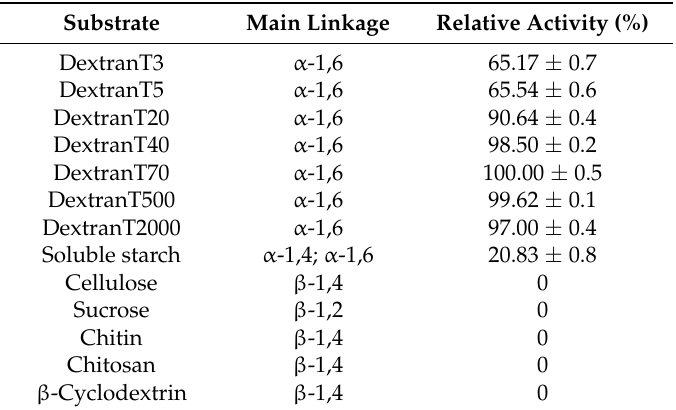
Table 2. Effects of dextranase on diverse carbohydrates.